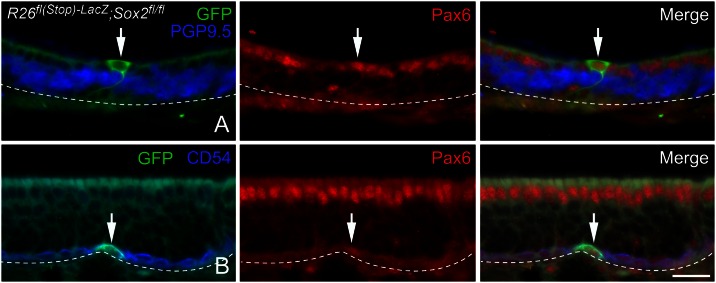
Pax6 expression remains unaltered within Sus cells and HBCs upon conditional deletion of Sox2.Clones from tissue harvested 3-weeks after Cre RVV-transduction of bigenic R26fl(stop)-LacZ; Sox2flox/flox mice were immunolabeled for the neuronal marker PGP9.5 (A) or the HBC marker CD54 (B), along with Pax6 and GFP. In clones containing GFP (+)/ PGP9.5 (-) Sus cells (A), situated above the neural strata (arrows), Pax6 expression remains indistinguishable from surrounding untransduced Sus cells. In clones containing GFP (+)/CD54 (+) HBCs (B), Pax6 levels remain indistinguishable from untransduced HBCs (arrows). Arrowheads mark the basal lamina and scale bar corresponds to 20 μm and applies to all panels.